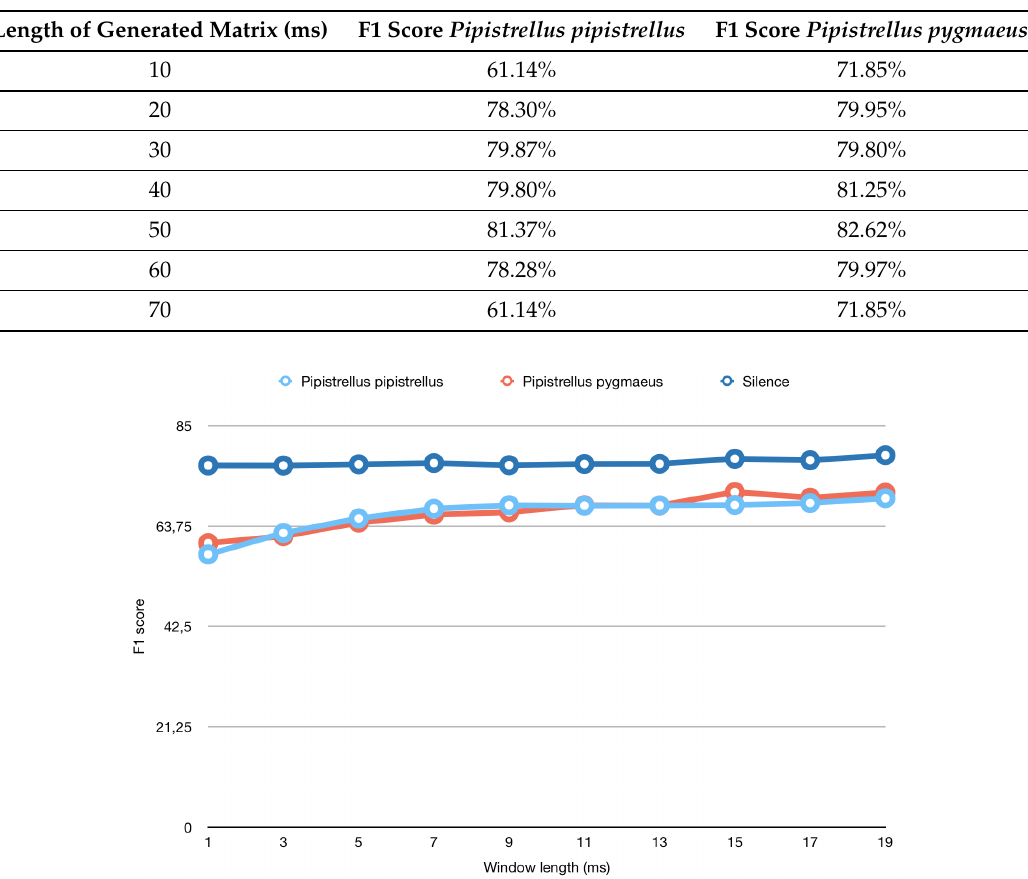
Figure 12. F1 score results of each window length obtained with the filter bank parameterization and the Feedforward Neural Network (FNN).